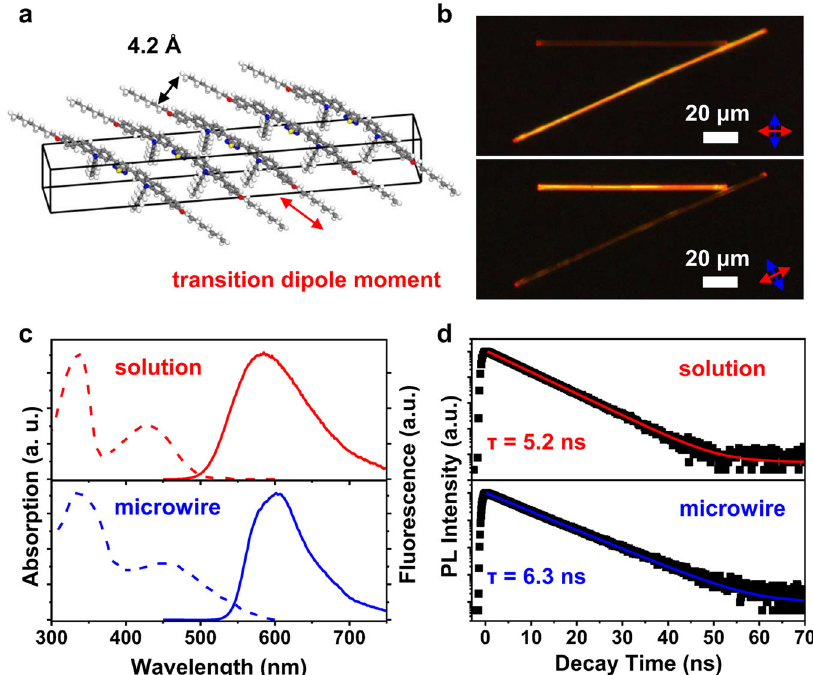
Fig. 2 Packing style and fl uorescence properties of BPCBT microwires. a Schematic illustration of molecular packing and TDM direction in the BPCBT microwire. b POM images of two crossed microwires. The arrows indicate the direction of optical polarizers. c Absorption and photoluminescence spectra of the dilute solution (red) and the microwire (blue) of BPCBT. Excitation wavelength in photoluminescence measurement is 400nm. d Photoluminescence decay curves from the BPCBT solution and the microwires. Excitation and emission wavelengths are 400 and 585 nm,